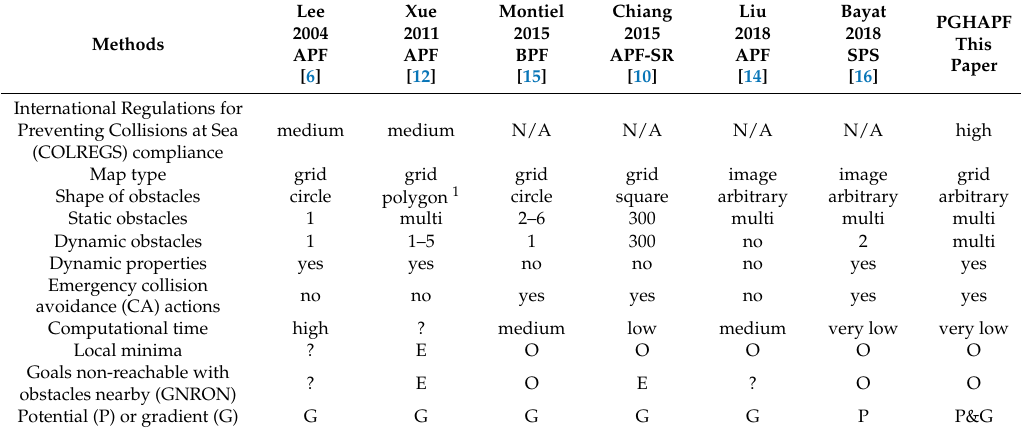
Table 1. Comparison among different selected path planning methods and the authors’ method; artificial potential field (APF); bacterial potential field (BPF); APF-stochastic reachable (APF-SR); scalar potential surface (SPS); path-guided hybrid artificial potential field